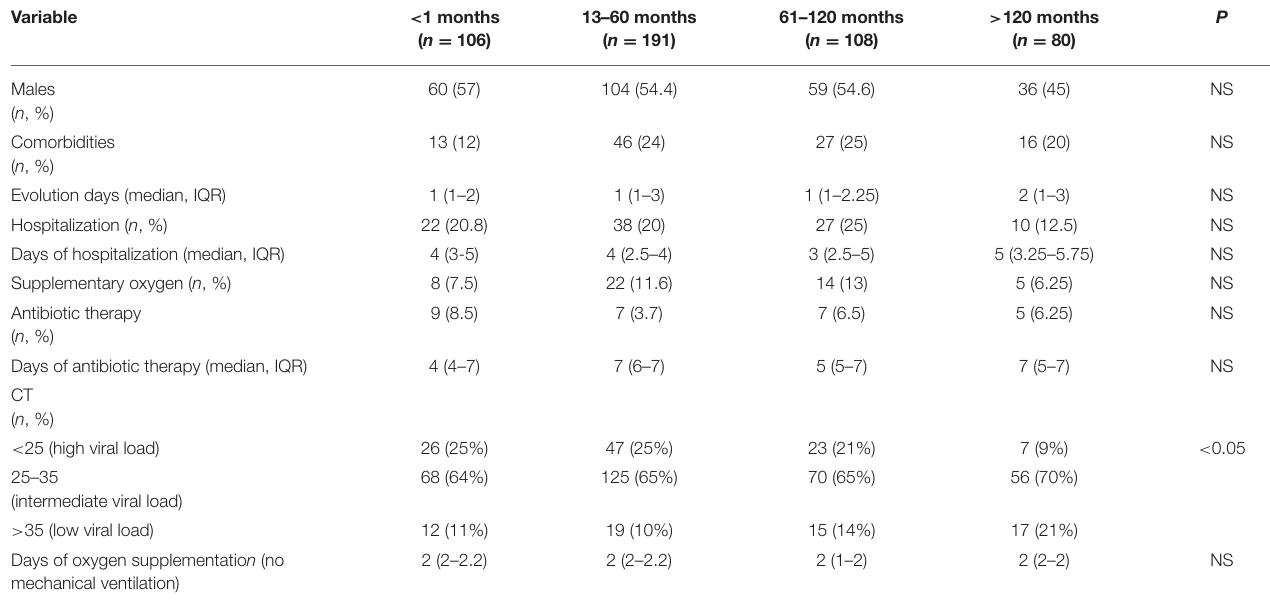
TABLE 2 | Clinical and laboratory characteristics distributed by age group of patients ( n = 485).